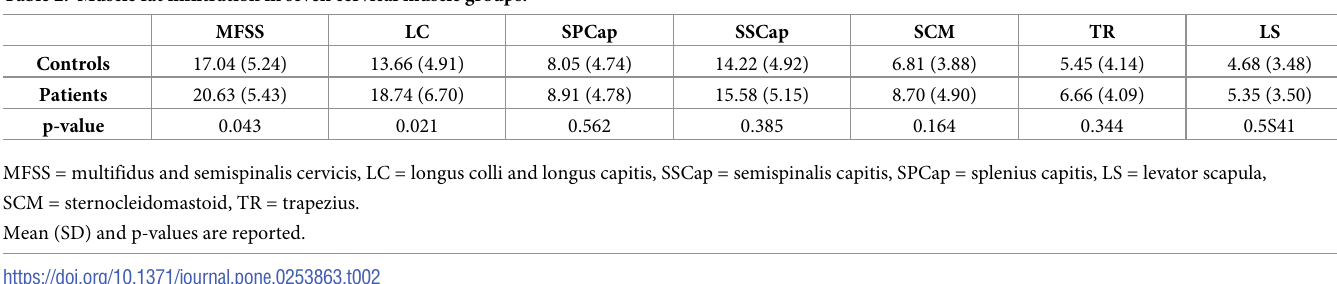
Table 2. Muscle fat infiltration in seven cervical muscle groups. MFSS